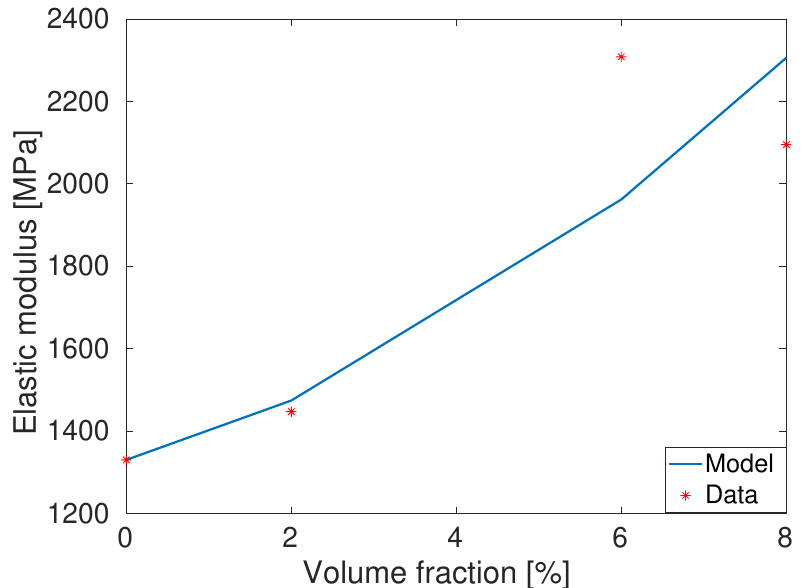
Figure 7. Model fitting of the elastic moduli at various fraction of PET-GNP